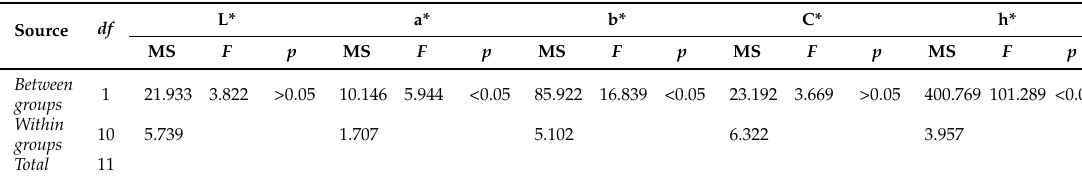
Figure 3. Colorimetric analysis of L*, a*, b*, C*, and h* parameters in “control” and “experimental” samples of sea urchin roe. Table 1. Results of one-way ANOVA for the effect of fraudulent substitution in the colour spaces of sea urchin roe L*, a*, b*, C*, and